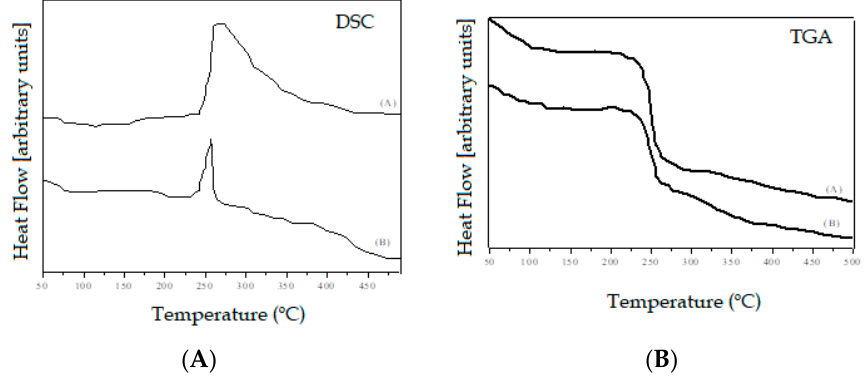
Figure 3. Differential Scanning Calorimetry (DSC) analysis (left-hand panel) of the ( A ) hydrogel alginate/gelatin (80:20) and ( B ) hydrogel with silver nanoparticles (AgNPs) (4 mM); Thermogravimetric (TGA) analysis (right-hand panel) of ( A ) hydrogel alginate/gelatin (80:20), and ( B ) hydrogel with AgNPs (4 mM).